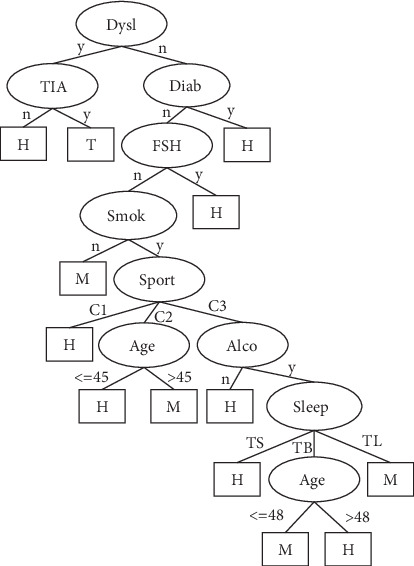
Decision tree #2 to classify risk factors of stroke.